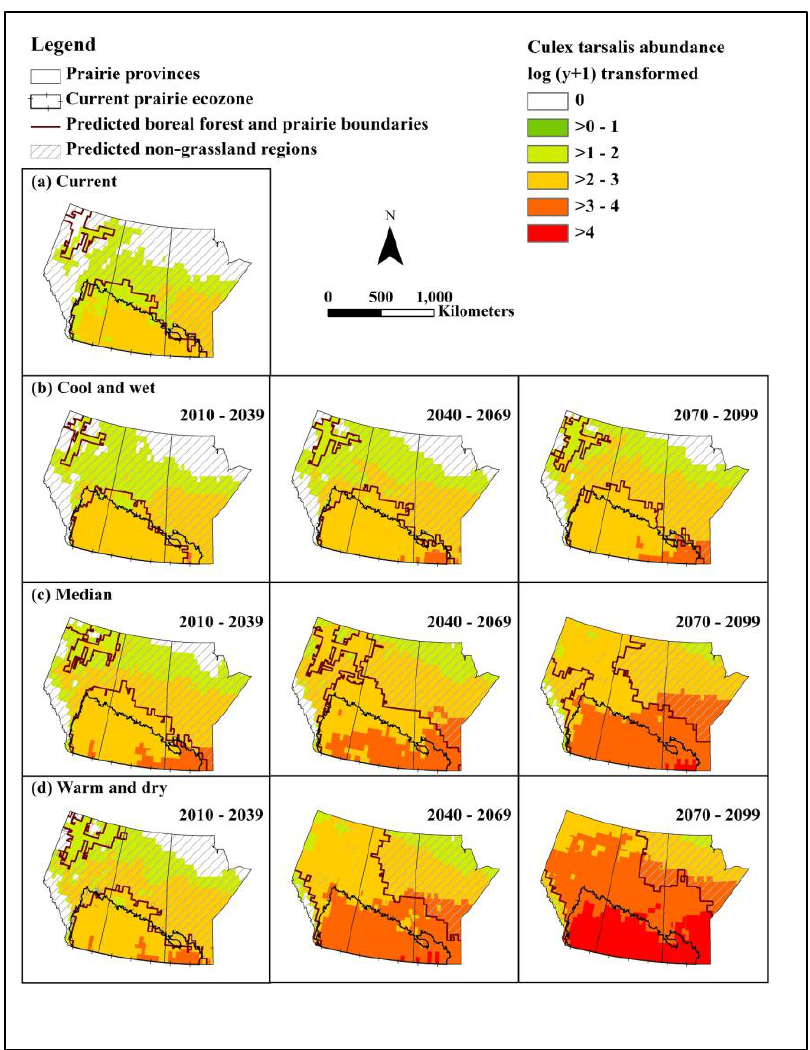
Figure 2. Projected spatial distribution and abundance, log (y+1) transformed, of Cx. tarsalis in August in the prairie provinces under current and selected outcome scenarios in three future time slices. The possible spatial distribution of Cx. tarsalis restricted by the predicted grassland distribution is indicated by the solid red